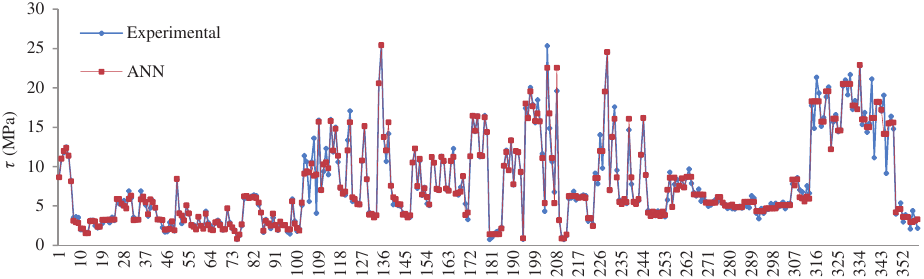
Figure 12: Comparison of the ANN model output and experimental data for training.